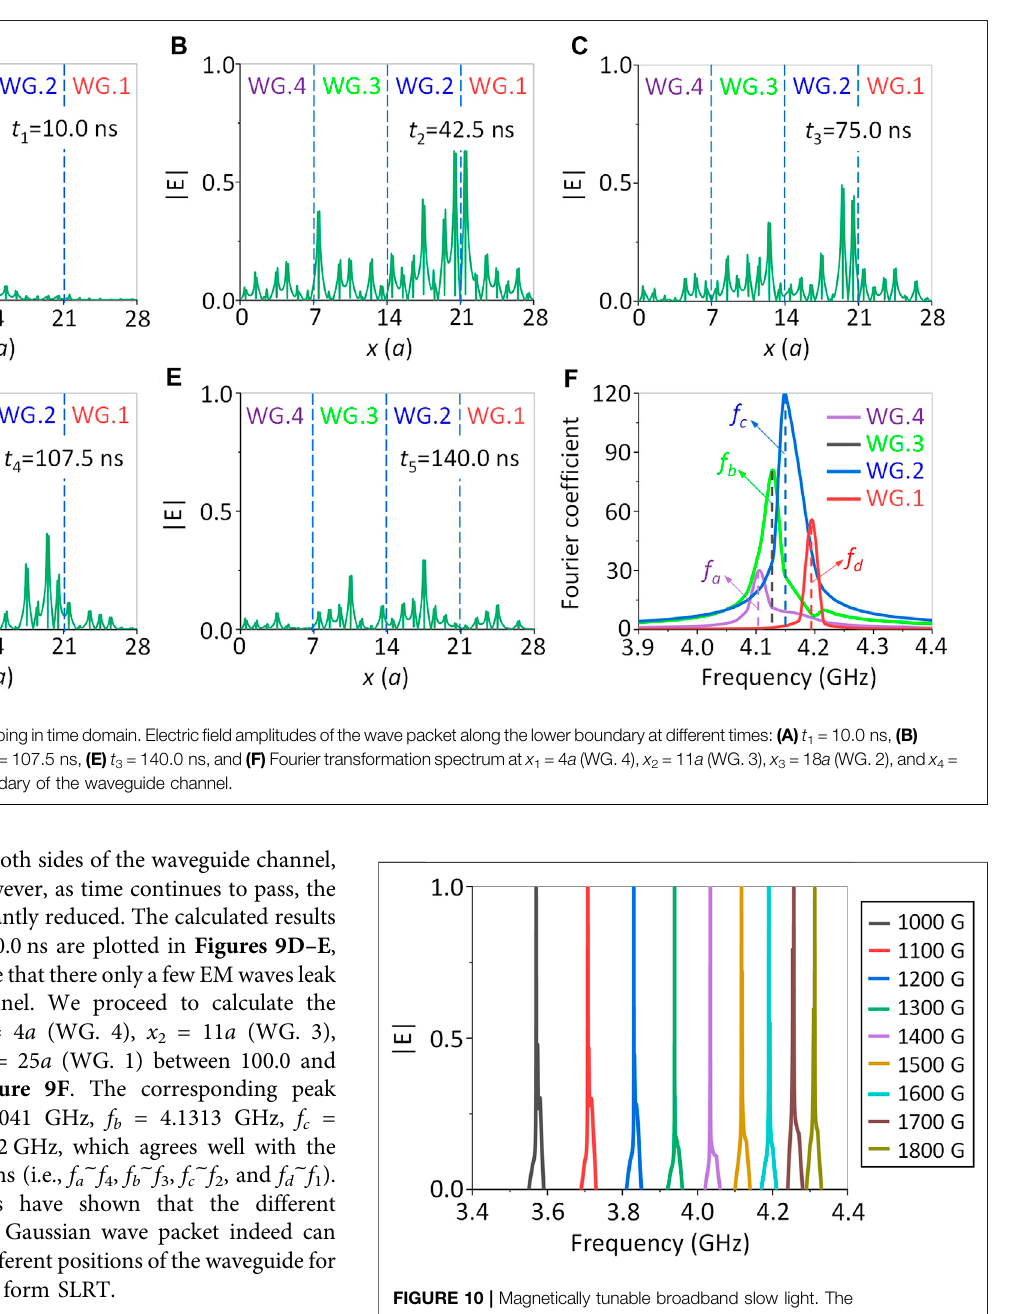
FIGURE 10 | Magnetically tunable broadband slow light. The frequencies of slow light states are 3.5701, 3.7078, 3.8301, 3.9385, 4.0340, 4.1171,4.1902,4.2562,and4.3121 GHzundertheexternal magnetic fi eldof 1,000, 1,100, 1,200, 1,300, 1,400, 1,500, 1,600, 1700, and 1800 G,